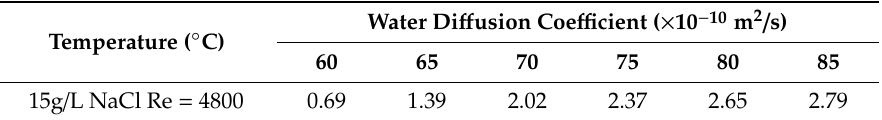
Table 1. Apparent di ff usion coe ffi cient of water at di ff erent temperatures.